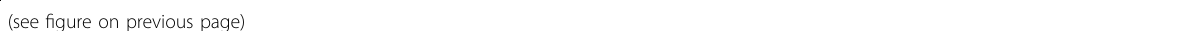
Fig. 5 Activation of the dDpMe shuts down cataplexy attacks in mice with orexin neuronal lesions. a Schematic of a celltype-speci fi c lesion combined with optogenetic stimulation and poly-graphic recordings of the dDpMe in mice. Left-most, orexin-stained neurons in the LH are present in the control group but absent in the caspase-3 lesion group. Right-most, Images of dDpMe AAV-Vgat-ChR2-mCherry neurons co-labelled with GAD2 mRNA. b Example recordings of a wake-to-cataplexy transition, which contains EEG power spectrograms, EEG/EMG traces, and hypnograms. c The time, total amount, counts, and mean duration of cataplexy in wild-type mice between the control group and lesion group over a 12-h night period. Regarding the amount of time, signi fi cant differences were assessed by two-way ANOVA for time course (posthoc Sidak ’ s multiple comparisons tests): lesion group vs control group, F 1, 72 = 104.7, P < 0.001. The difference in total amount of 12-h night time, counts, and mean duration of cataplexy between the two groups were assessed by Student ’ s t-test , P < 0.001. d Example recordings of EEG power spectrograms, EEG/ EMG traces, and hypnograms in wild-type mice, with bilateral blue-light stimulation (bottom, 470 nm, 30 Hz, 5 ms, 120 s) or yellow-light stimulation (top, 593 nm, 30 Hz, 5 ms, 120 s) of dDpMe GABA neurons. e Time courses of cataplexy, theta ratio, the probability of major stage, and EMG integral in wild-type mice after 2 min control (593-nm) or 470-nm laser stimulation of dDpMe ChR2-mCherry-expressing neurons initiated from cataplexy. The red lines indicate a statistical difference between the ChR2-mCherry and mCherry groups ( P < 0.01). EMG integral assessed by Student ’ s t-test ( P < 0.01). f EEG power spectrograms, EEG/EMG traces, and hypnograms of wild-type mice with orexin neuronal lesions following the application of 3-h light stimulation (30 Hz, 5 s per 30 s) in dDpMe GABA ChR2 neurons. g Difference in the time and total amount of cataplexy in wild-type mice between the control group and lesion group during 3-h light stimulation. Regarding the time, signi fi cant differences were assessed by two-way ANOVA for time course (post-hoc Sidak ’ s multiple comparisons tests): *lesion group vs control group, F 1, 72 = 7.117, P = 0.0094. Differences in the total amount of each brain state during 3-h light stimulation were assessed by Student ’ s t-test . P = 0.0036. Data represent means ± SEM. * P < 0.05, ** P < 0.01. ns nigrostriatal bundle, f